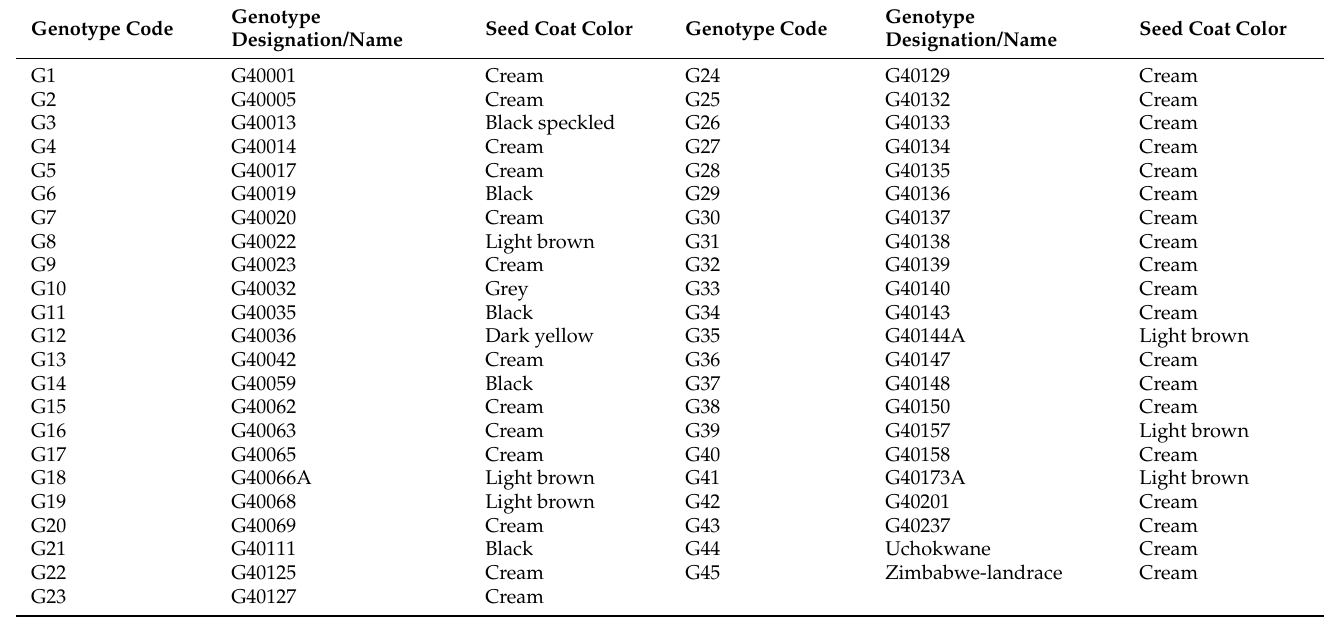
Table 3. Genotype codes, names, and seed coat colours of tepary bean accessions used in the